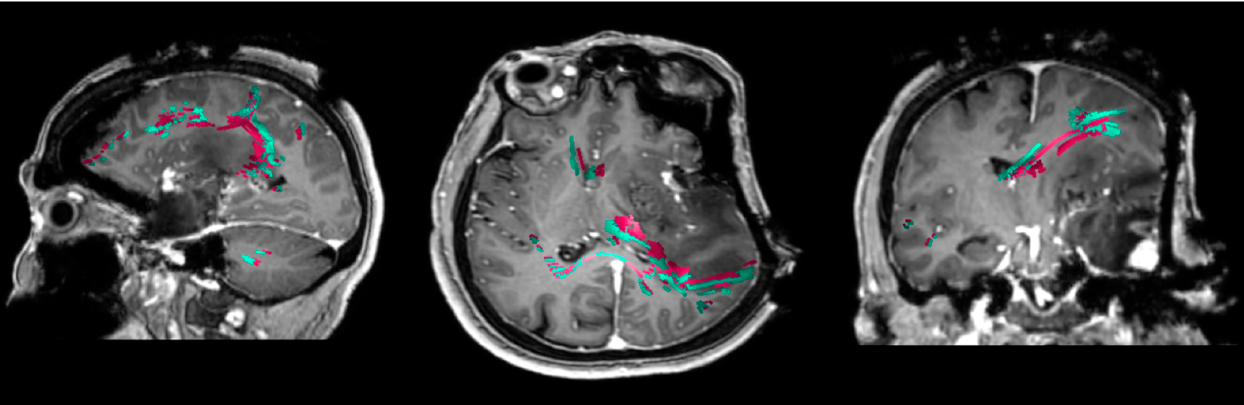
Figure 2. nTMS-based language tractography corrected by IBEF in an ioMRI scan. This figure shows motor fiber tracts based on navigated transcranial magnetic stimulation (nTMS) in an intraoperative magnetic resonance imaging (ioMRI) scan in an exemplary patient case. The preoperative motor fiber tracts are shown in pink. The fiber tracts corrected by ioMRI-based elastic fusion (IBEF) are shown in cyan.